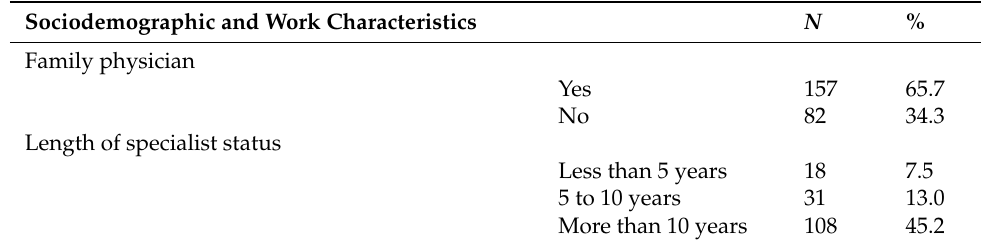
Table 2. Sociodemographic and work characteristics of respondents, group of physicians ( N = 239).